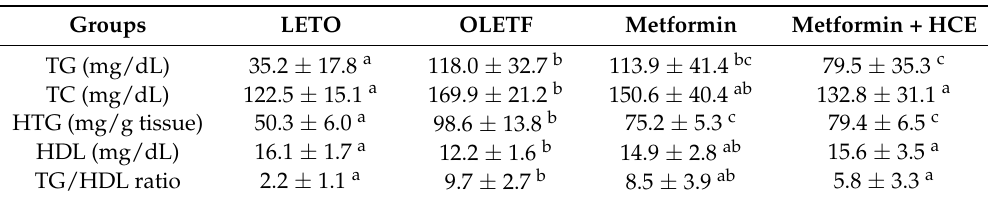
Table 1. Serum lipid parameters of the different experimental